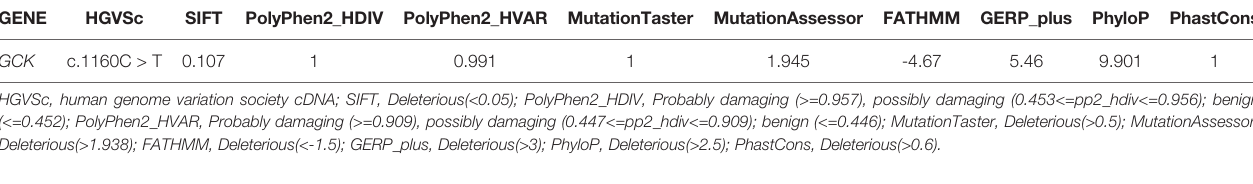
TABLE 5 | Sanger sequencing results of candidate gene loci in family members of the proband. GENE